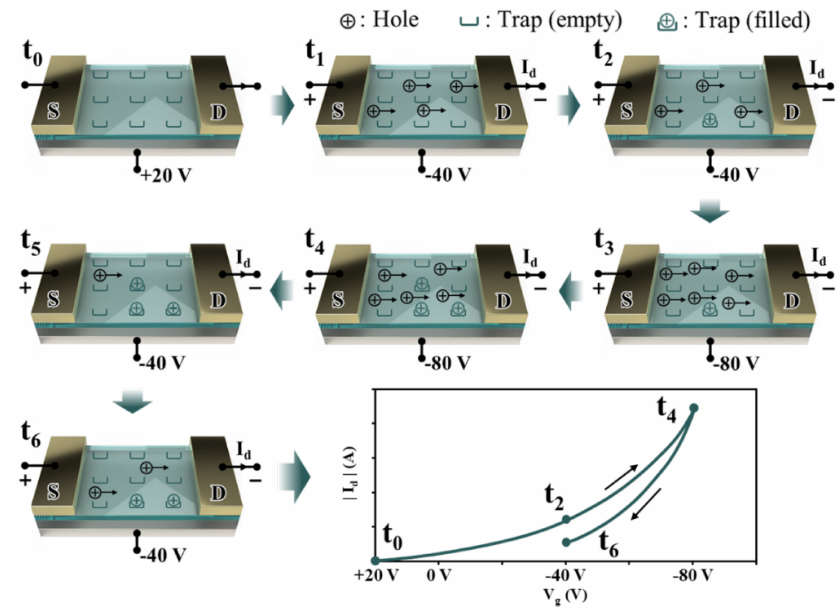
Figure 10. Pentacene FET transient behavior during a gate-voltage sweep